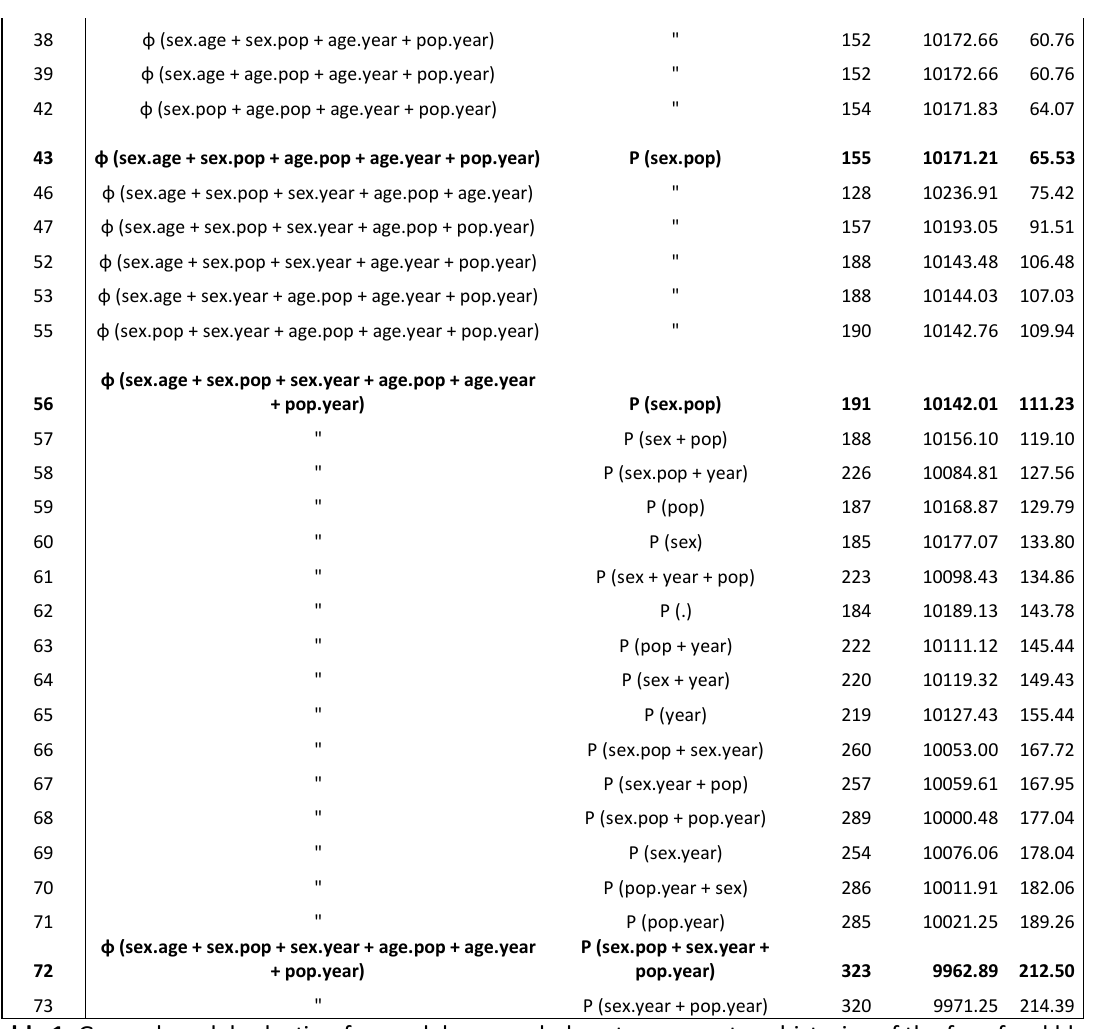
Table 1 : General model selection for models on pooled capture-recapture histories of the four focal blue tit populations, to test for the importance of age, sex, population (pop) and annual variation (year) on survival (φ) and recapture (P) probabilities. When a first order interaction between two variables is indicated, both non-interactive terms are present in the model even if not explicitly mentioned